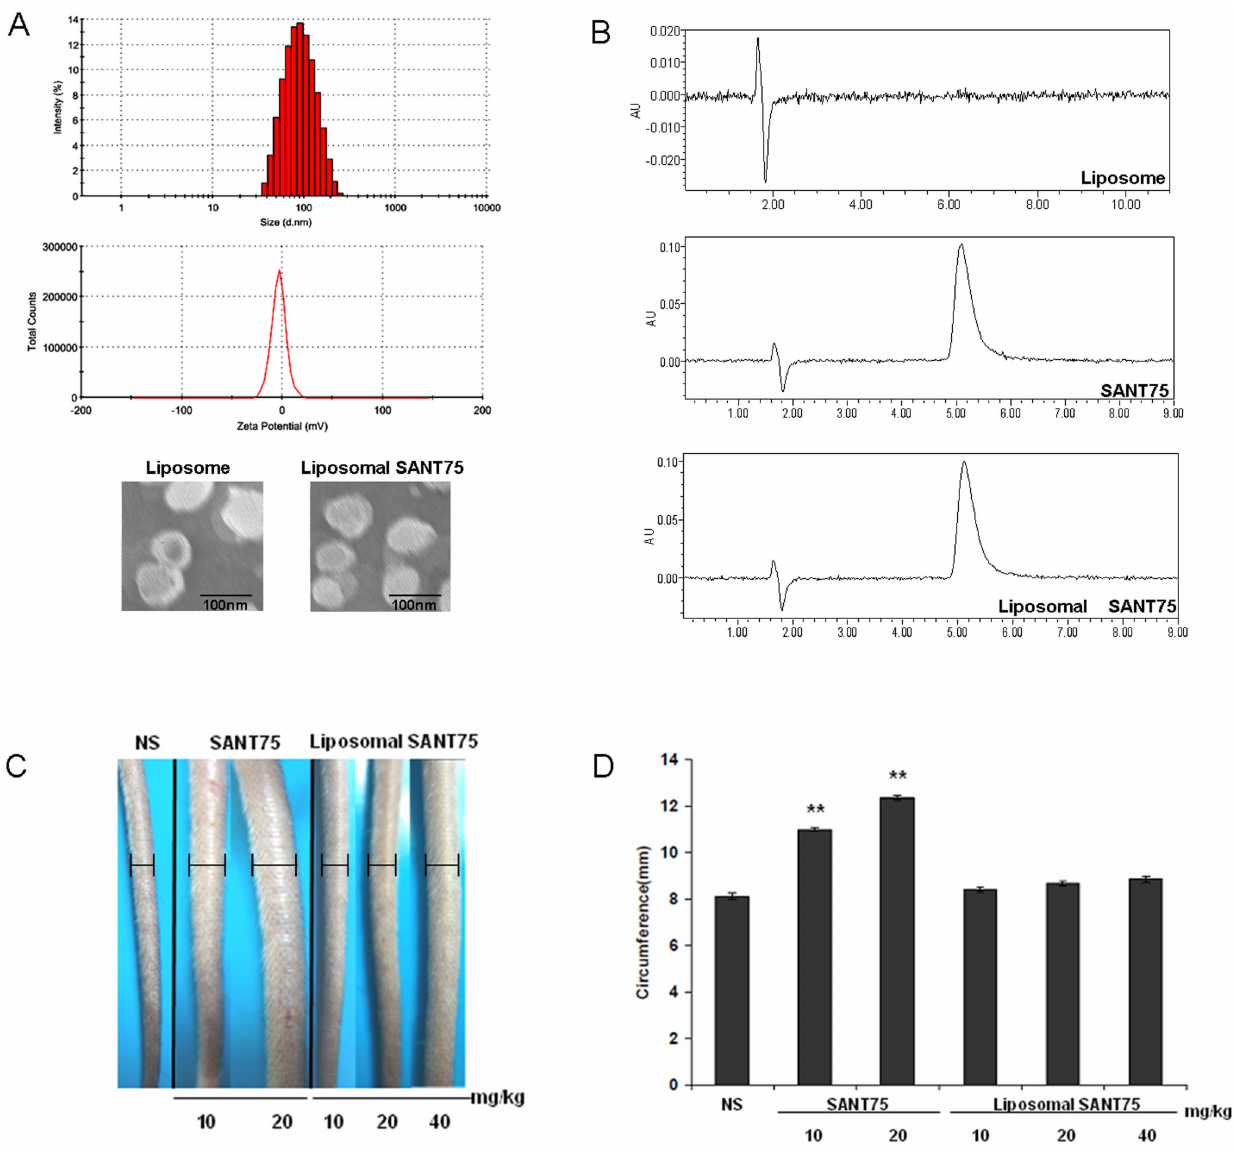
Figure 1. The characterization and the decreased toxicity of liposomal SANT75. (A) Size distribution, zeta potential spectrum and the morphologic photomicrographs of liposomal SANT75. (B) The HPLC analysis of free liposome, SANT75, and liposomal SANT75. (C) Photograph of mice tails after i.v. of free SANT75 and liposomal SANT75 with various doses. (D) The statistics of the mouse tail circumferences reflecting the severity of swelling in different groups. Columns, mean; bars, SD. **, P , 0.01, SANT75 group versus the normal saline (NS) or liposomal SANT75